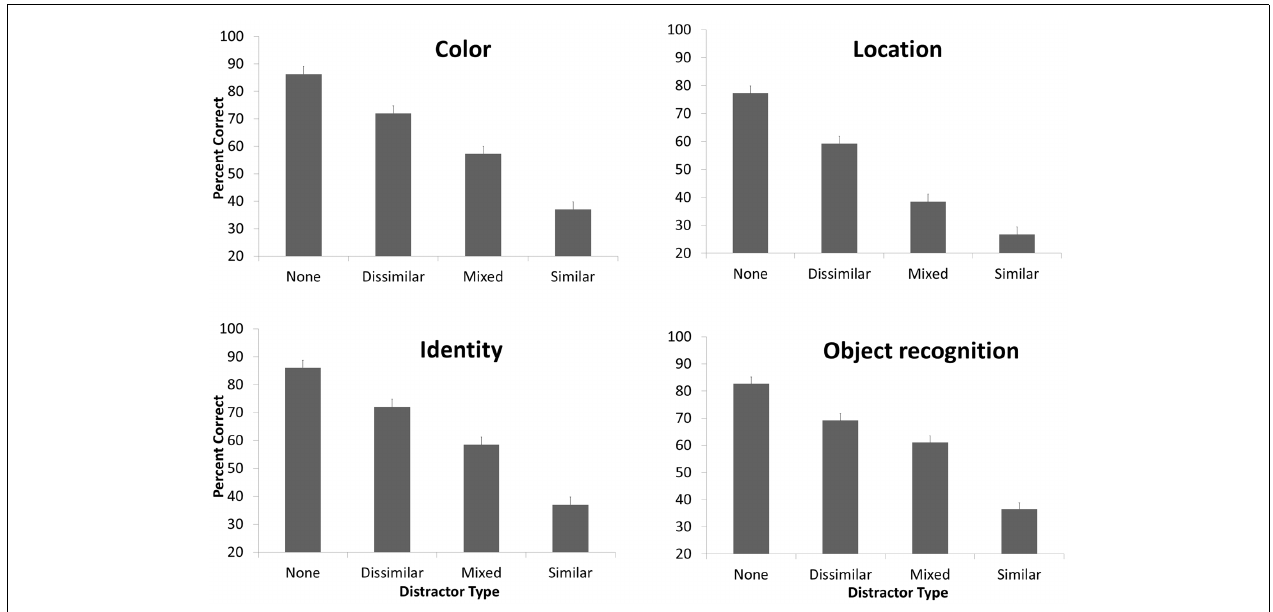
FIGURE 4 | Memory performance for each of the four question types, for each of the four experimental conditions. See the caption of Figure 3 for details of the conditions. Error bars show 1